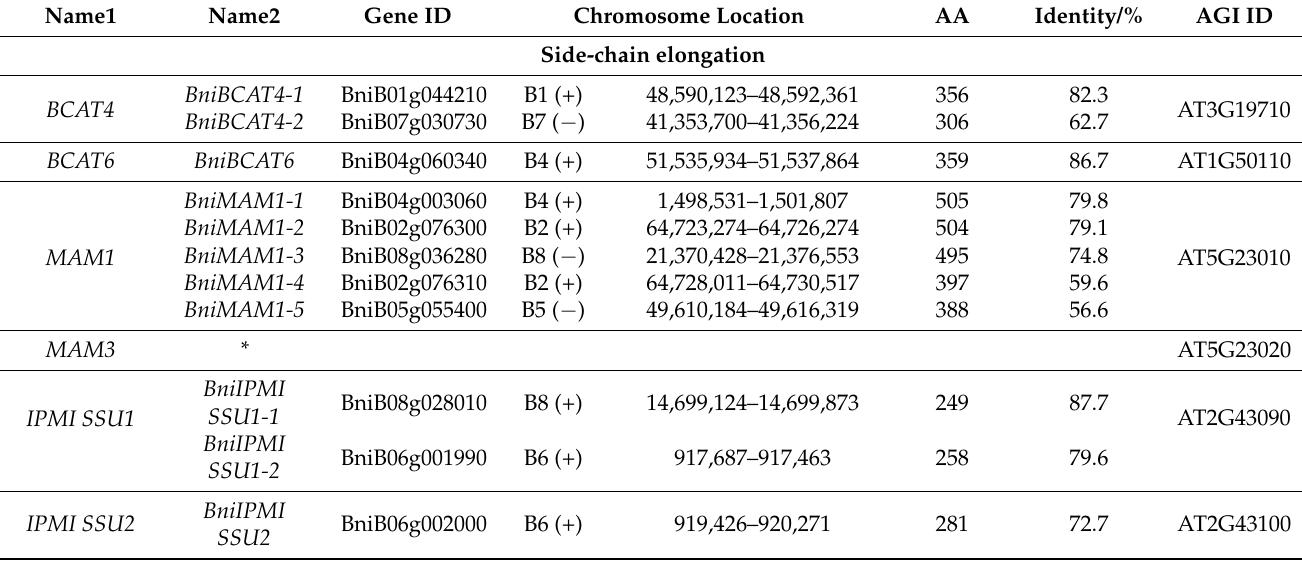
Table 2. The inventory of glucosinolate biosynthetic genes ( BniGSLs ) in Brassica nigra